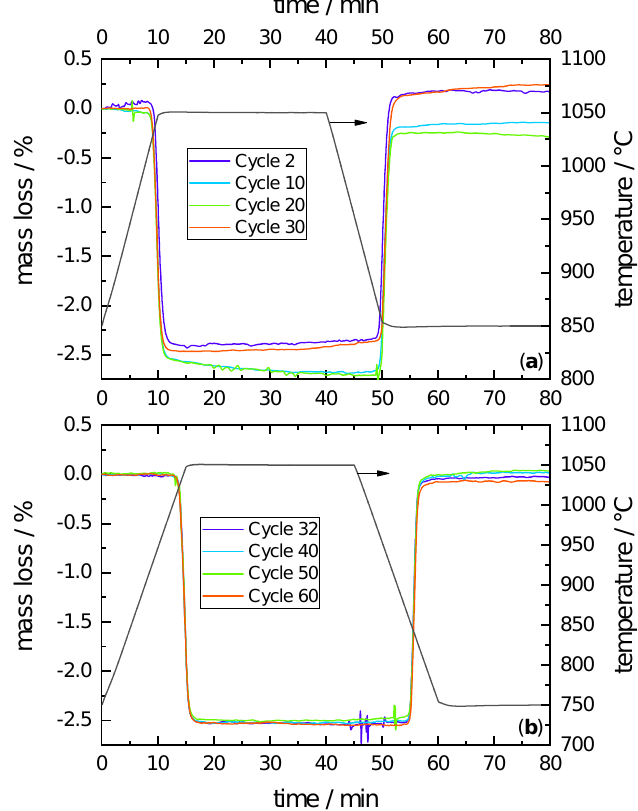
Figure A1. Relative mass loss of the manganese–iron oxide compound during several redox cycles performed in TGA with an oxygen partial pressure of 20kPa and a heating and cooling rate of 20K/min. ( a ) The sample temperature was varied between 850 ◦ C and 1050 ◦ C during the first 30 redox cycles. ( b ) The next 30 redox cycles were carried out between a sample temperature of 750 ◦ C and 1050 ◦